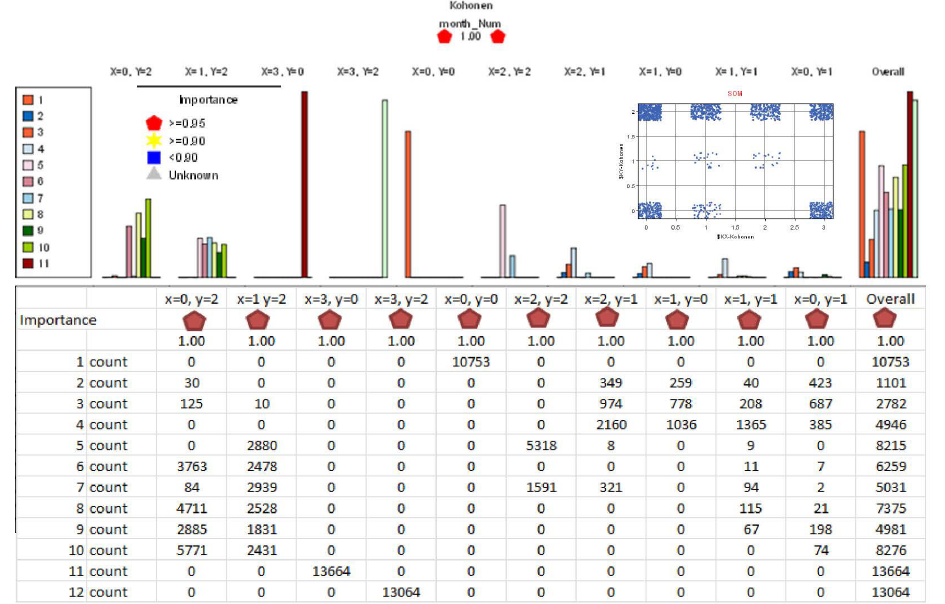
Figure 7. Plot of X-Kohonen and Y-Kohonen with agitation showing the SOM clusters (insert in top